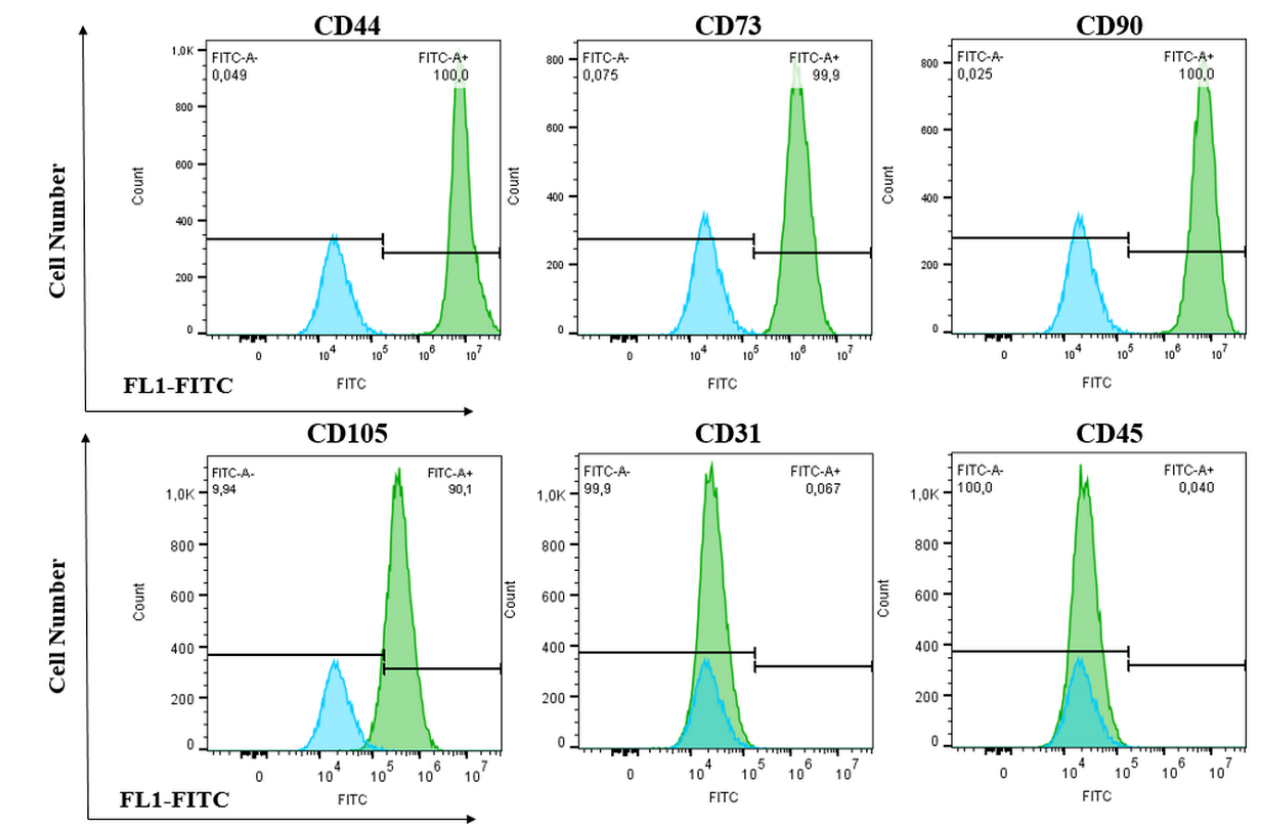
Figure 2. MSC-like marker expression of MAFs. Histograms show cell surface antigen expression of MAFs (green) compared to unstained control (blue), n =